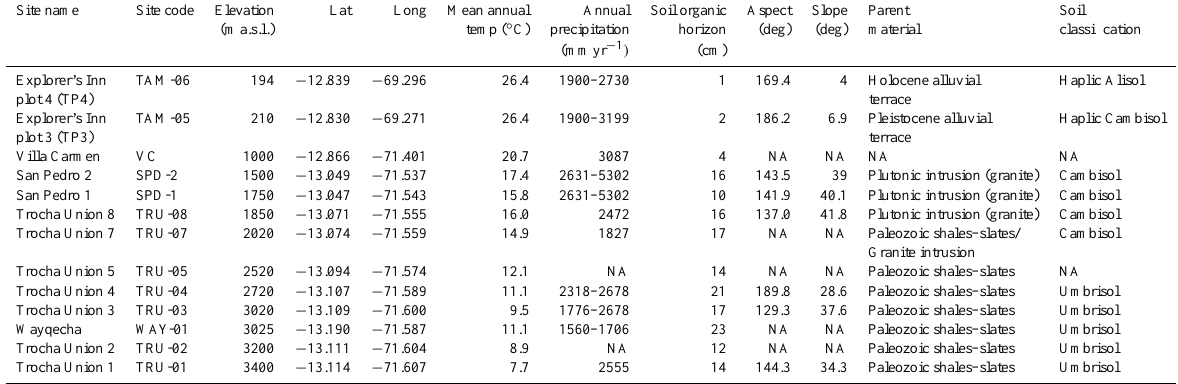
Table 1. Summary of site characteristics along the elevation gradient, spanning lowland rainforest (194–210ma.s.l.),